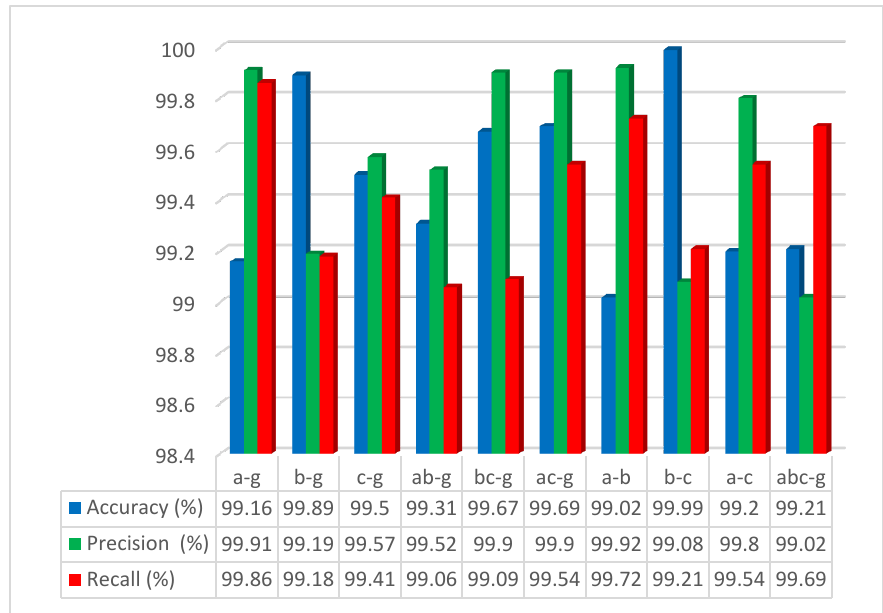
Table 1. The average accuracy of the fault detection.